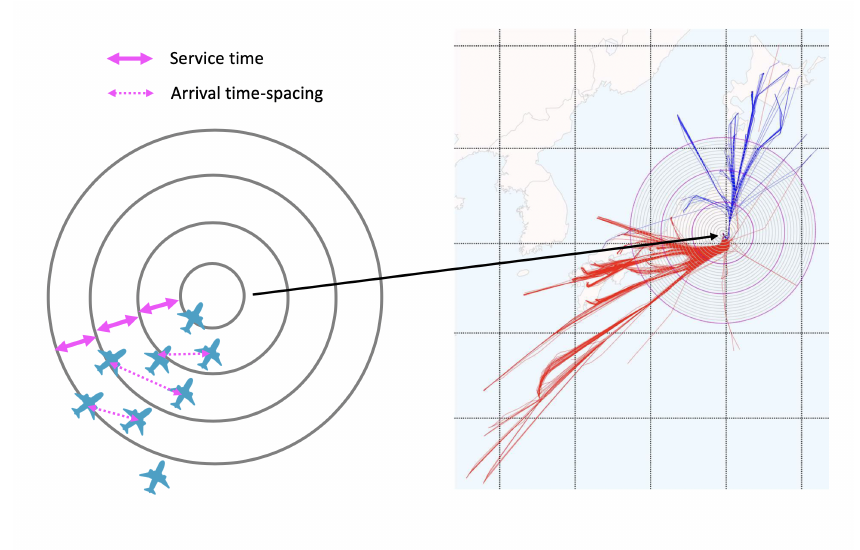
Figure 7. Illustration of the service time and inter-arrival